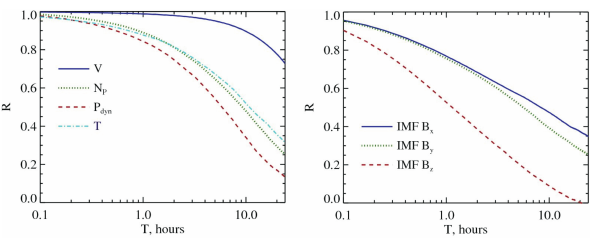
Figure 4. Autocorrelation coefficients for four principal character- istics of the solar wind (left) and three IMF components (right) as functions of the time lag T in hours. The plots are based on 5min average OMNI data in 19 yearly files